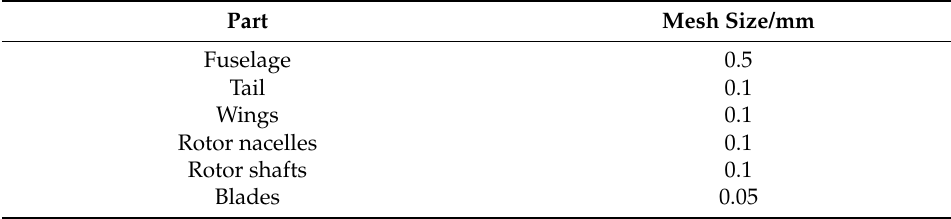
Figure 1. Aircraft geometry model divided into triangle elements. Table 1. Sizes of mesh generations of different parts of aircraft model.